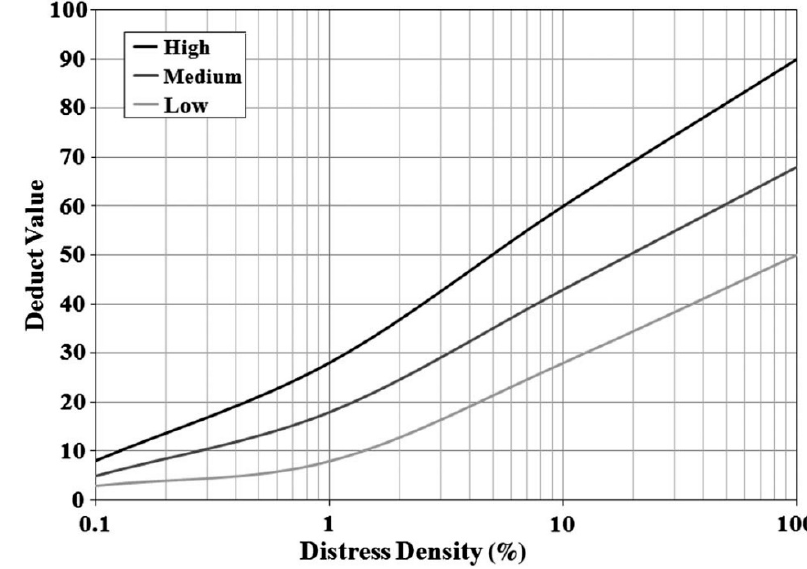
Figure 2. Typical deduct value calculation curve [3].